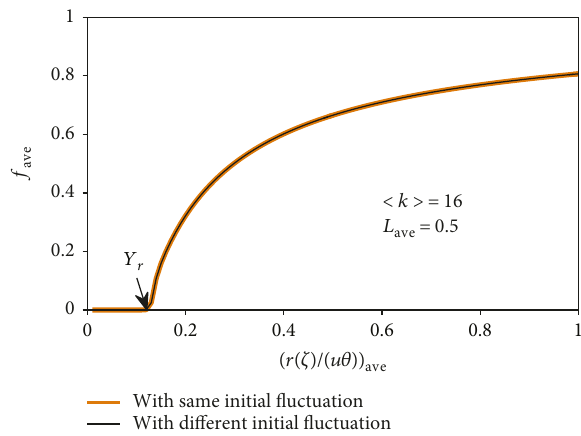
Figure 13: The average intensity of individual risk contagion with di ff erent average value y ave